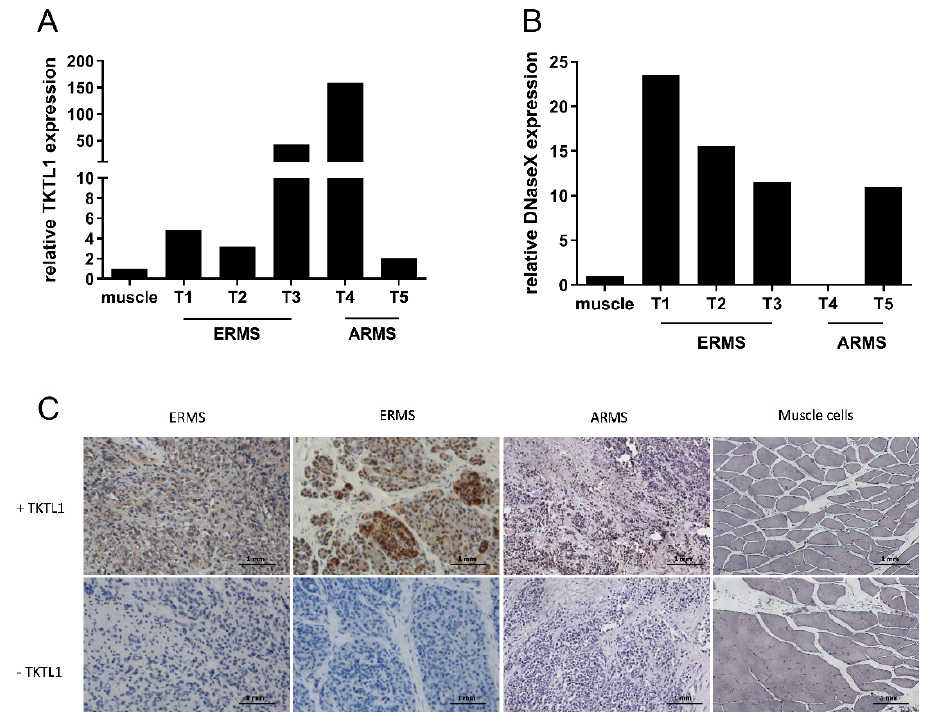
Figure 2. Expression of TKTL1 and DNaseX/Apo10 in tumor material from the patients. Transcrip- tional expression of TKTL1 ( A ) and Apo10 ( B ) in tissue samples from patients with RMS. Quantitative RT-PCR was performed to quantify mRNA levels, with TBP as a housekeeping gene. The expression levels are relative values (patient samples were compared to the respective control muscle tissues). ARMS: alveolar rhabdomyosarcoma; ERMS: embryonal rhabdomyosarcoma; Tx: number of the tumor sample. ( C ) Hematoxylin and eosin staining (control) and TKTL1 staining of ERMS, ARMS, and muscle tissue paraffin sections. Original magnification, ×20.